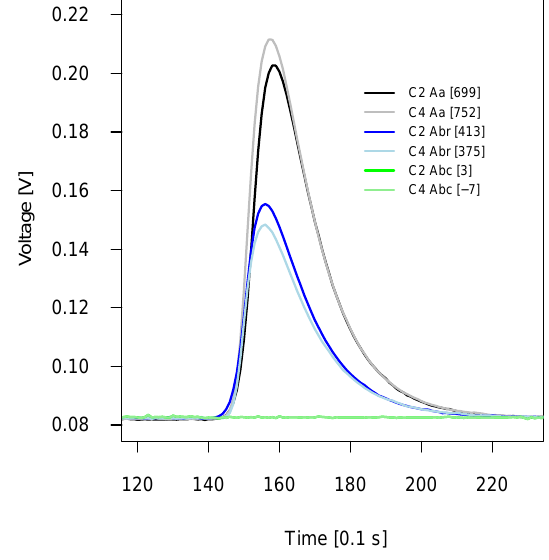
Figure 3. Representative peak recovery for gold cartridge pair C2– C4 during ambient air (Aa), GEM reference gas (Abr) and dry, Hg- free air measurements (Abc) on 11 February 2012, between 14:00 and 15:30 in Basel. The values in squared brackets equal the areas between the curves and the baseline. The plots show an extract of 10s from the peak delay sequence which takes 30 seconds in total. Y axis indicates the Hg detector baseline voltage